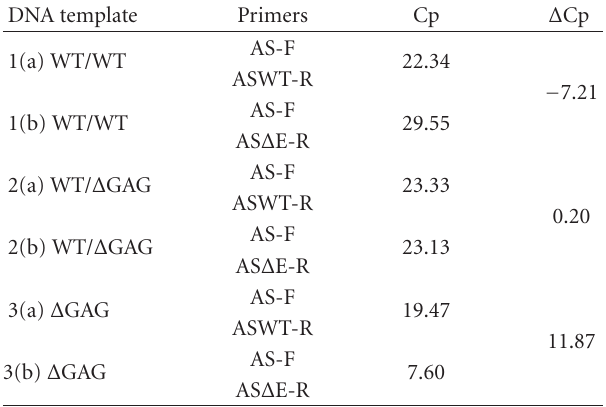
Table 1: A ffi nity of allele-specific primers for the wildtype (WT) and the Δ GAG allele of